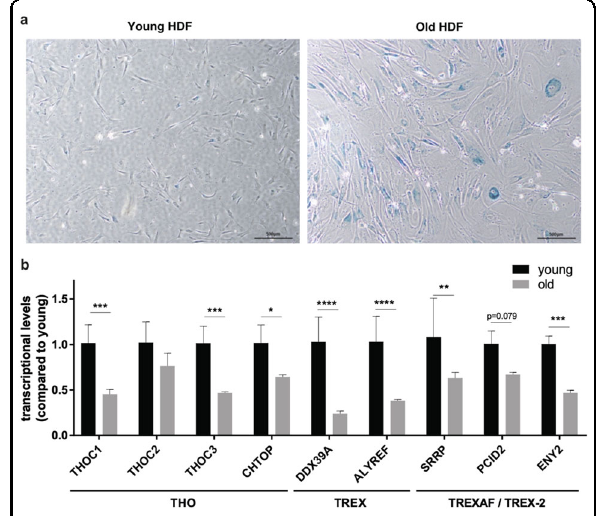
Fig. 3 The downregulation of TREXes is associated with cellular senescence. a Positive staining of β -galactosidase in replicative senescence models of human diploid fi broblasts (HDFs). Scale bar, 500 μ m. b qRT-PCR analysis of representative TREXes in the young and old